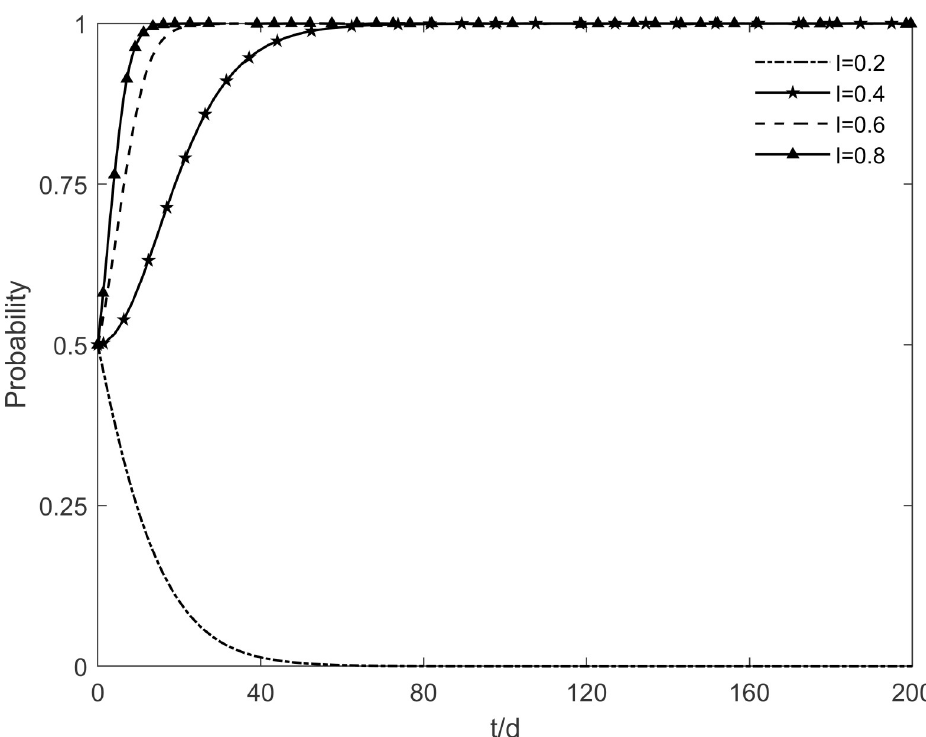
Fig 16. The impact of l on the investment retrofitting enterprises’ strategic choices.